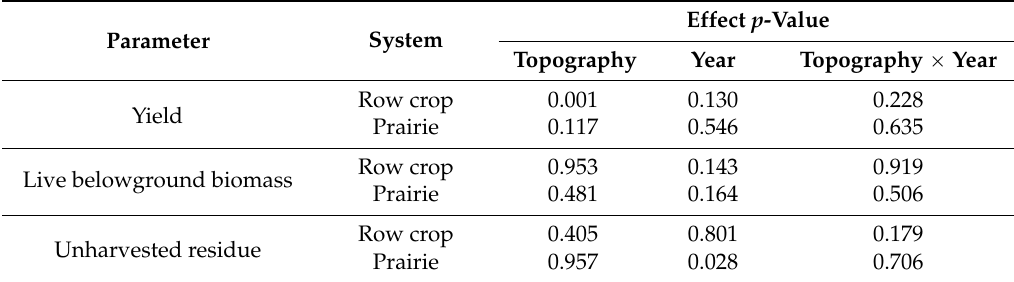
Table 2. ANOVA table summarizing the influence of topography and year on yield, unharvested biomass, and live belowground